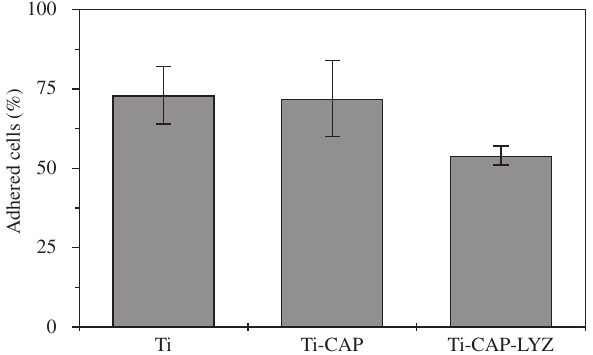
surfaces.Ti Figure 7. Percentage of adhered cells with relation to seeded cells onto pure Ti, CAP coated Ti and Ti-CAP-LYZ